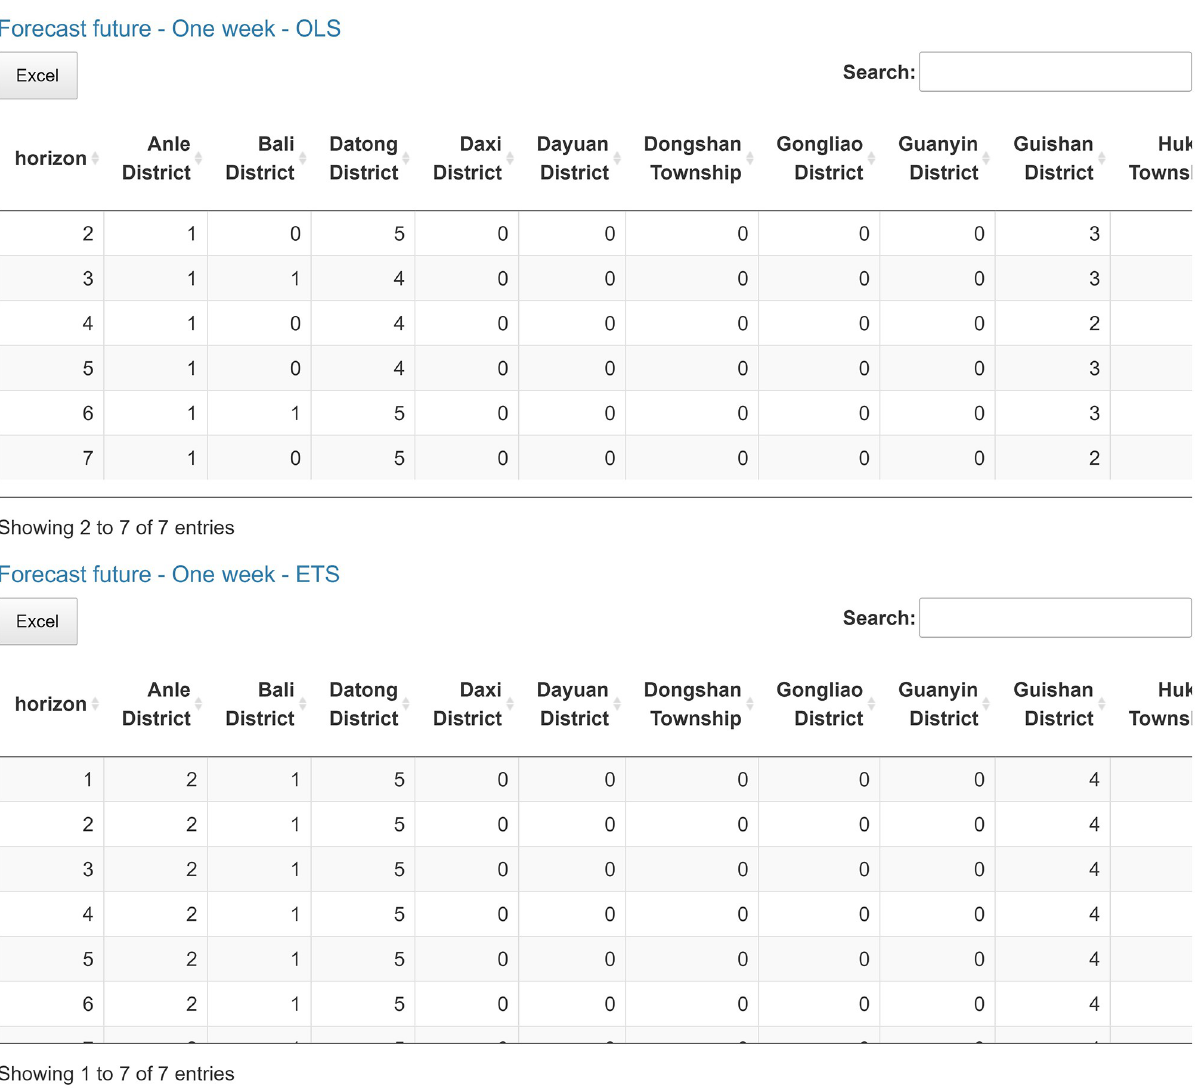
Fig 6. Clustering and forecasting Taiwan COVID-19 confirmed infection cases—Part